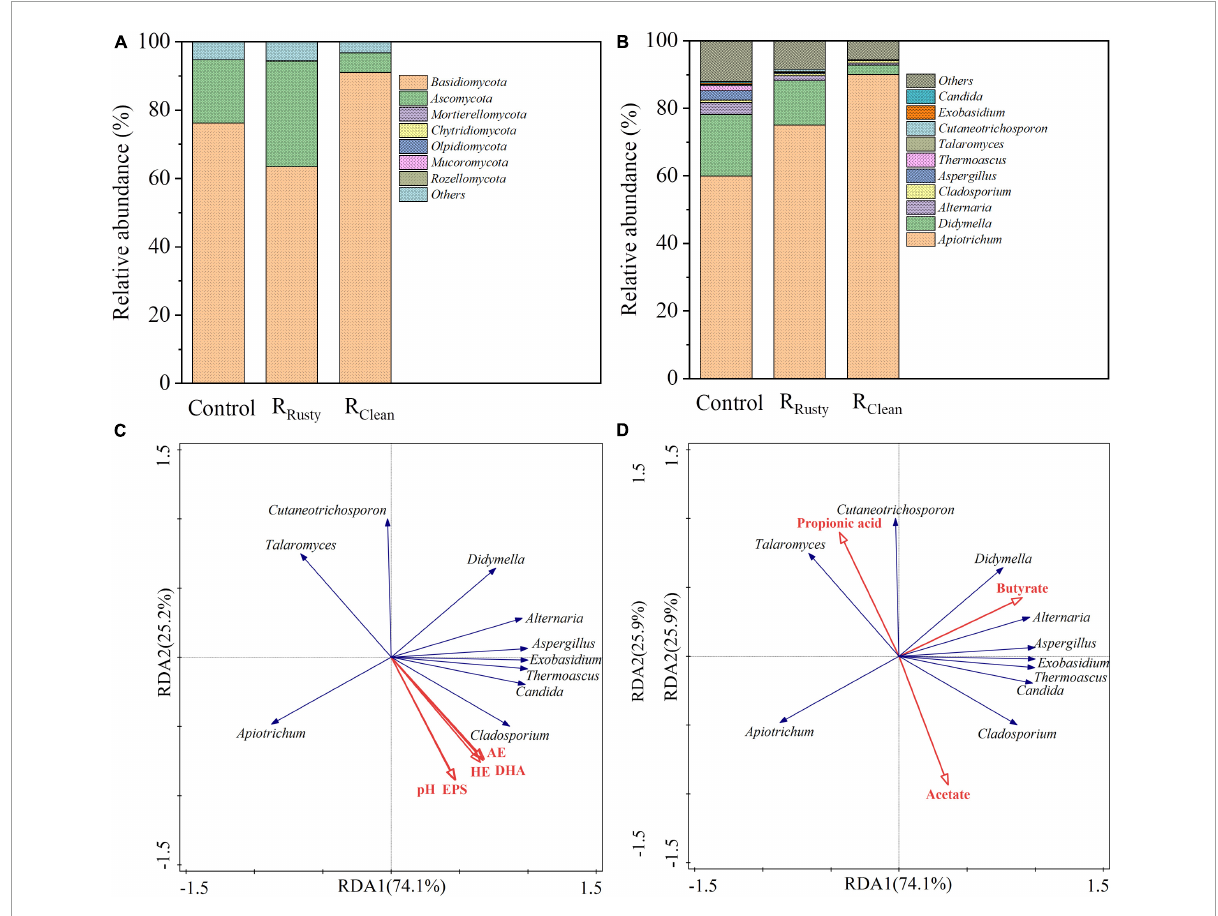
FIGURE4 Fungal communities. (A,B) Microbial community structure at the phylum and genus levels and (C,D) correlation between the microbial community and environmental factors for sludge samples based on redundancy